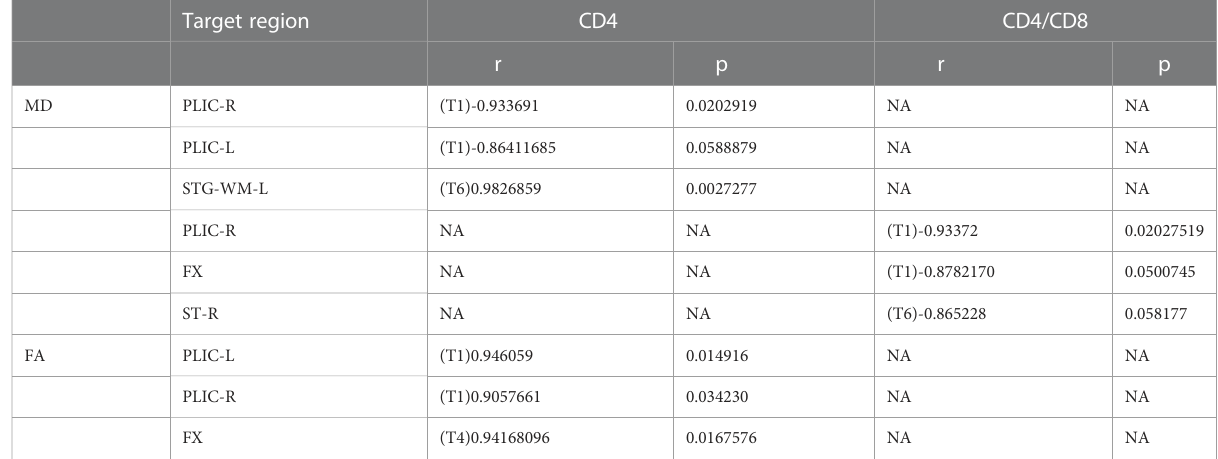
NA means without signi fi cant correlation. PLIC-R, Posterior Limb of the Internal Capsule – Right; PLIC-L, Posterior Limb of the Internal Capsule – Left; STG-WM-L, Superior TemporalGyrusWM – Left;FX,Fornix;ST-R,StriaTerminalus – Right;CP-R,CerebralPeduncle – Right.T1meanstimepoint1(thatisthebaseline);T6meanstimepoint6(thatis36 weeks post inoculation).